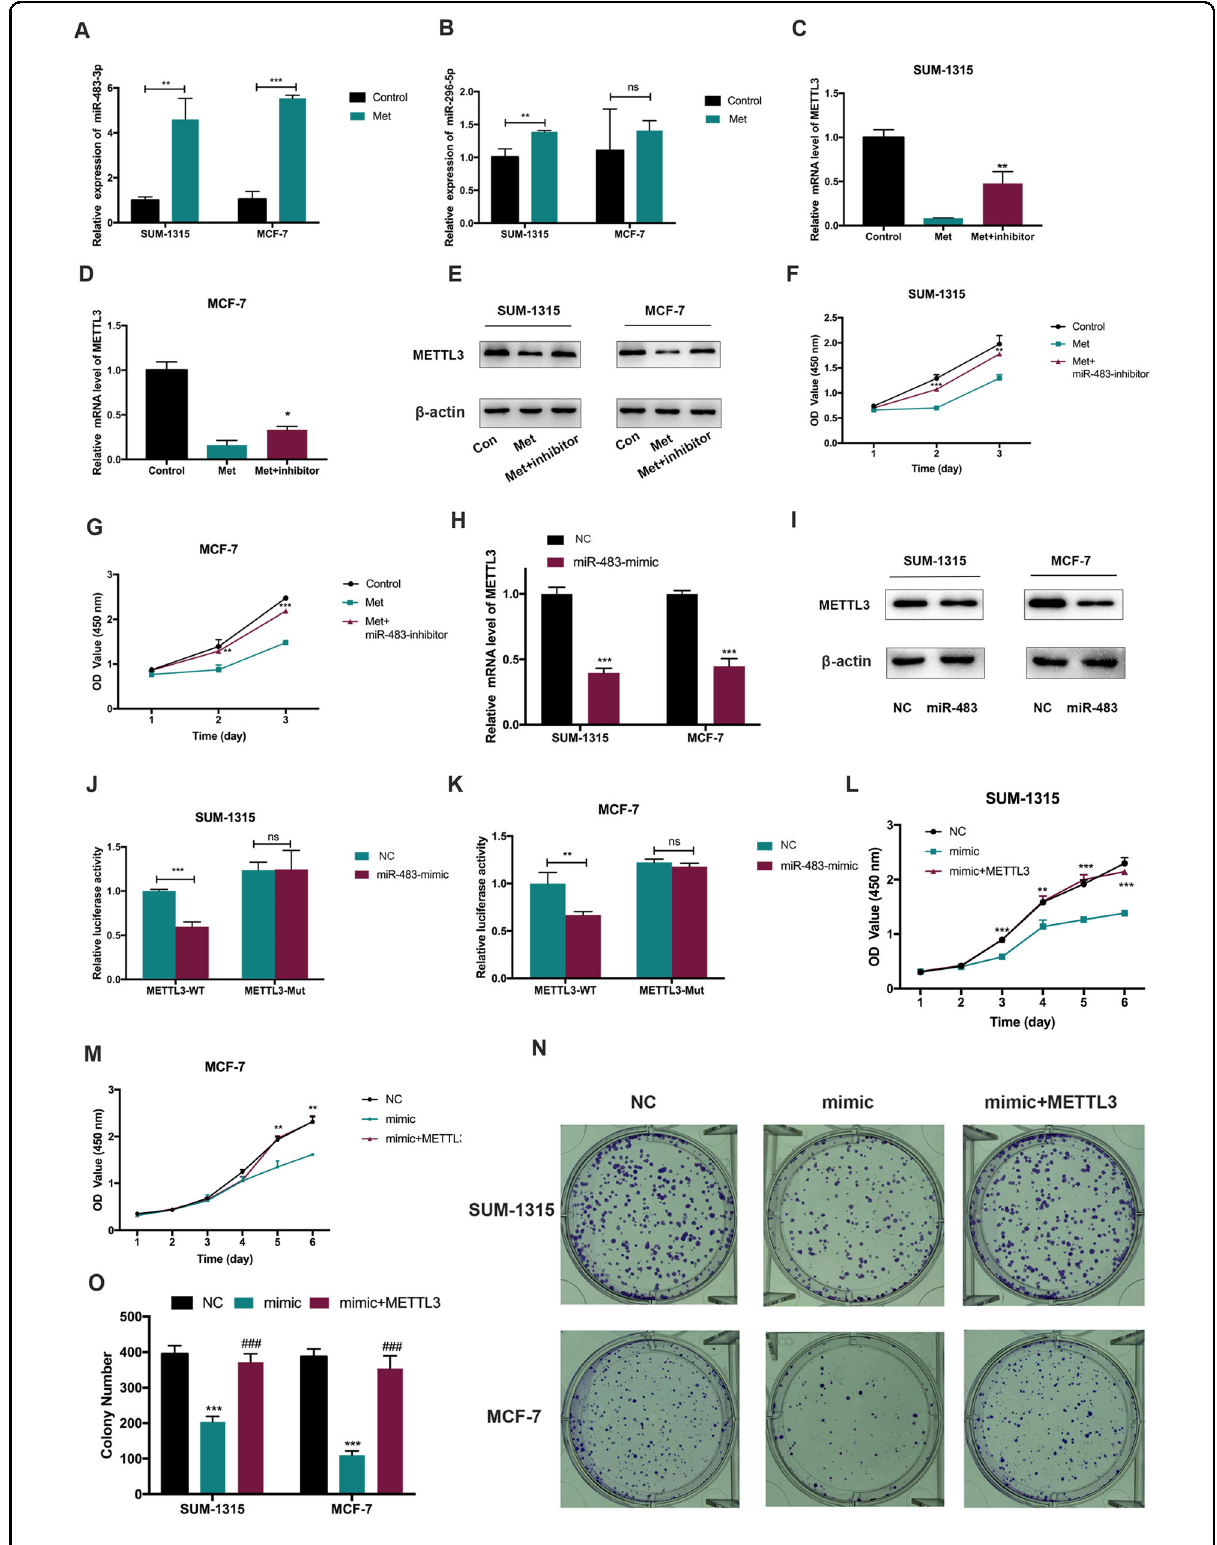
Fig. 6 (See legend on next